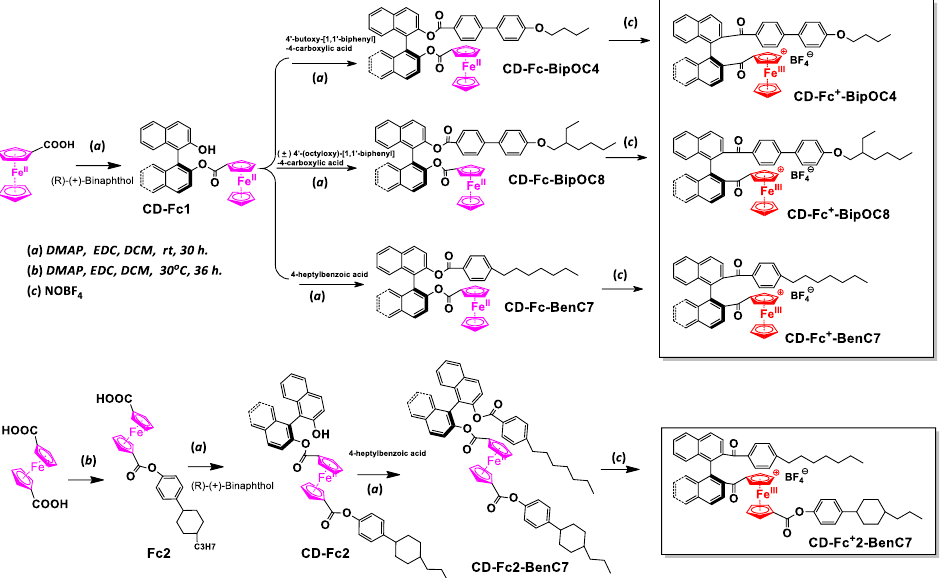
Figure 1. Synthetic routes of ferrocene chiral derivatives and ferrocene chiral ions (a) DMAP, EDC, rt, 30 h; (b) DMAP, EDC, 30 °C, 36 h; (c) NOBF 4